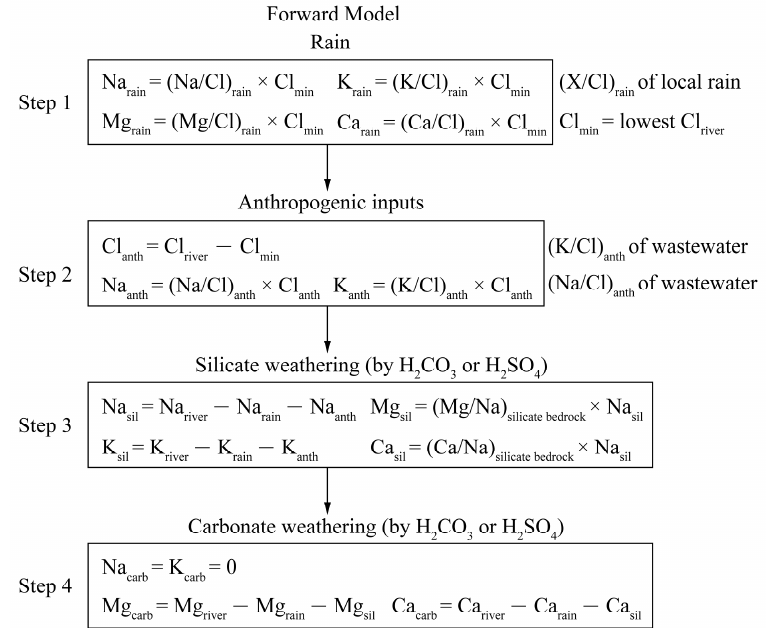
Figure 2. An outline of the forward model calculations for cations (K + , Na + , Ca 2+ and Mg 2+ ) from four major reservoirs (rain, anthropogenic inputs, silicate and carbonate weathering) in the JRB.